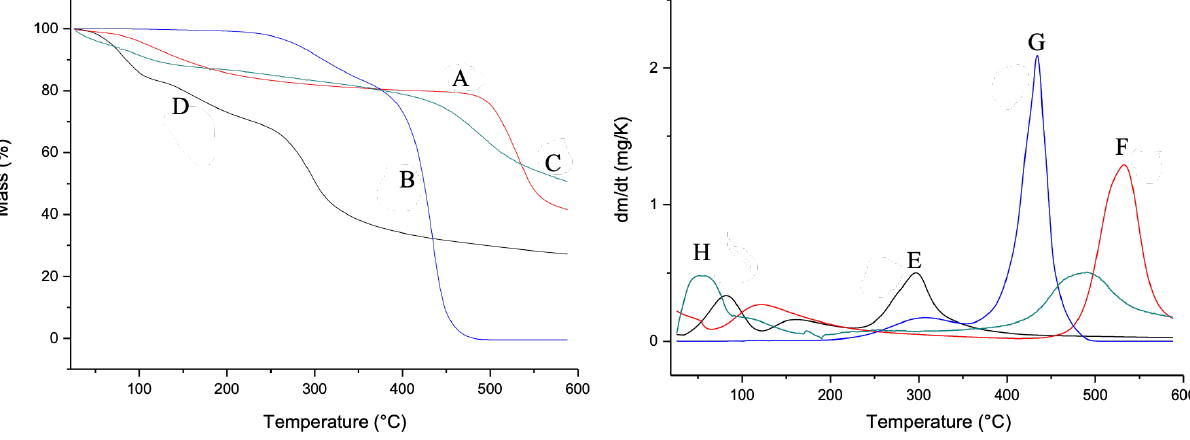
Figure 3. Thermogravimetric curves (TG) of (A) chicha gum (CG), (B) Mauritia flexuosa oil, (C) chicha gum/chitosan/ Mauritia flexuosa oil gel (CGCHO), and (D) chitosan-based gel (CHB). Derivative thermogravimetric curves (DTG) of CG (E), Mauritia flexuosa oil (F), CGCHO (G), and CHG (H).